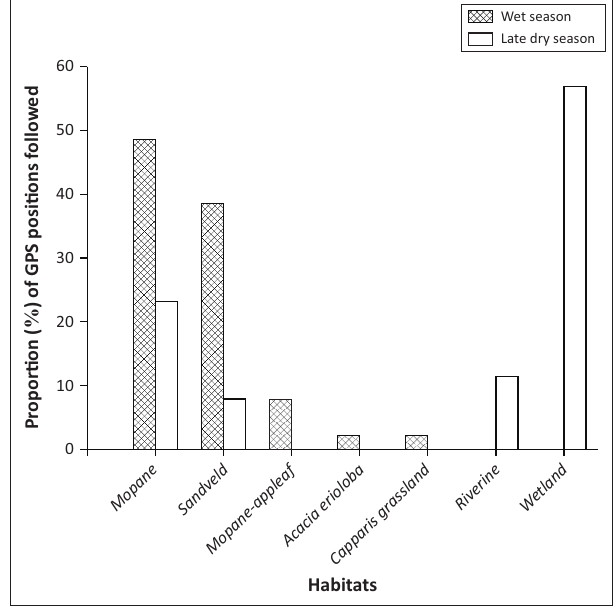
FIGURE 3: Percentage of various vegetation types observed in the follow-ups of GPS collar locations during the wet season and late dry